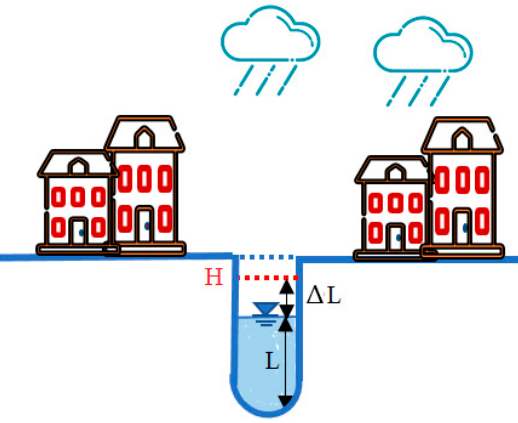
Figure 7. The water level analysis in the drainage system.